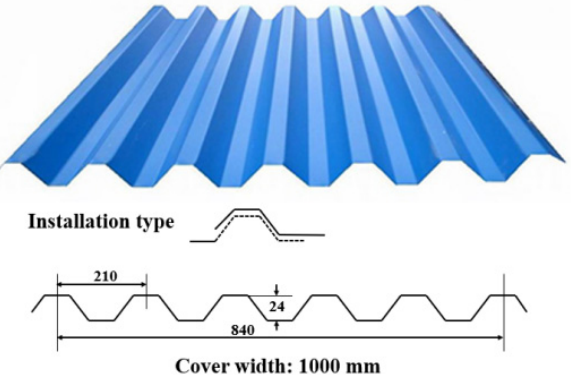
Figure 7. A kind of common color steel plate on the market. It is dangerous when burning. Second, the design of fire separation and evacuation in IS is inadequate. There is a lack of fire compartment in some buildings. For example, the facade of the building in Case 2 is barbed wire instead of solid wall, and in Case 11, the partition wall between the kitchen and the hall has not reached the ceiling, which failed to prevent the fire. In many houses, there is only one staircase and one exit; even worse, the evacuation channel is filled with combustible materials such as cartons and plastic bottles or parked with bicycles/electric bicycles. When a fire occurs, they will burn and generate a lot of heat and smoke to increase the fire, but also block the evacuation route. For many burning cases, the house was built with a middle staircase and surrounded by rooms according to residents’ living habits, and the internal structure is shown in Figure 8. In this structure, the only path to go up and down is the staircase in the middle that leads to the top, and the top is closed with glass for lighting. This type of house was called “Tongtian house”, which means the house can be directly connected to the heaven in Chinese. However, once a fire occurs, the middle are with the staircase of the building will serve as a chimney. Smoke spreads rapidly from bottom to top, and once the smoke starts to enter the stairwell, the stairwell becomes the smoke spreading channel, which overlaps with the personnel escape channel, leading to the failure of evacuation. In addition, as the roof is enclosed with glass, there is a large amount of heat and toxic smoke generated in the stairwell without exhausting, making it impossible for people to survive [41].